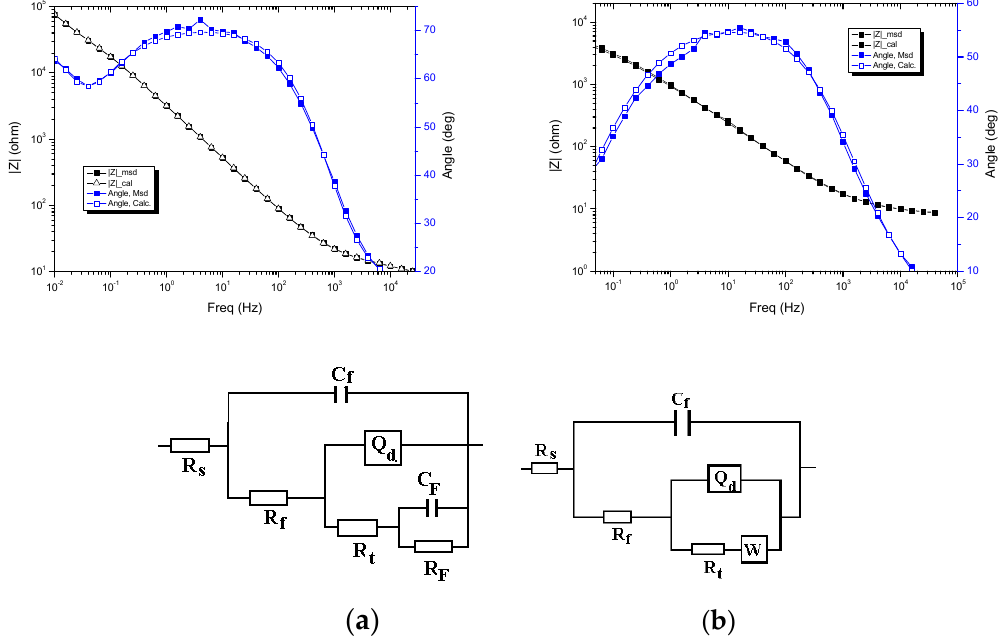
Figure 6. EIS data, Bode diagram, and equivalent circuit obtained for: ( a ) sample D1 and ( b ). sample